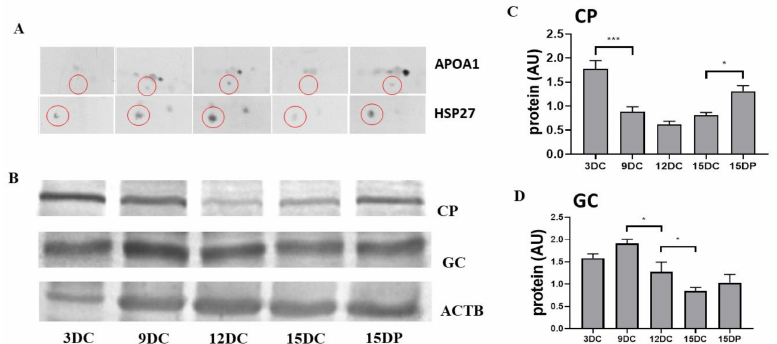
Figure 6. Western blot validation of change in abundances of proteins: ( A ) Abundance of proteins (red circles)APOA1 and HSP27 by 2D WB and ( B ) CP and GC by 1D WB in corpus luteum, selected for validation of 2DE. The statistical analysis of the protein abundance analysis of four biological repeats of ( C ) CP and ( D ) GC relative to the loading control (ACTB). Data were analyzed using one-way ANOVA with Sidak multiple comparison tests and are presented as mean ± SEM. AU—arbitrary units. * and *** indicate p < 0.05 and p < 0.001.